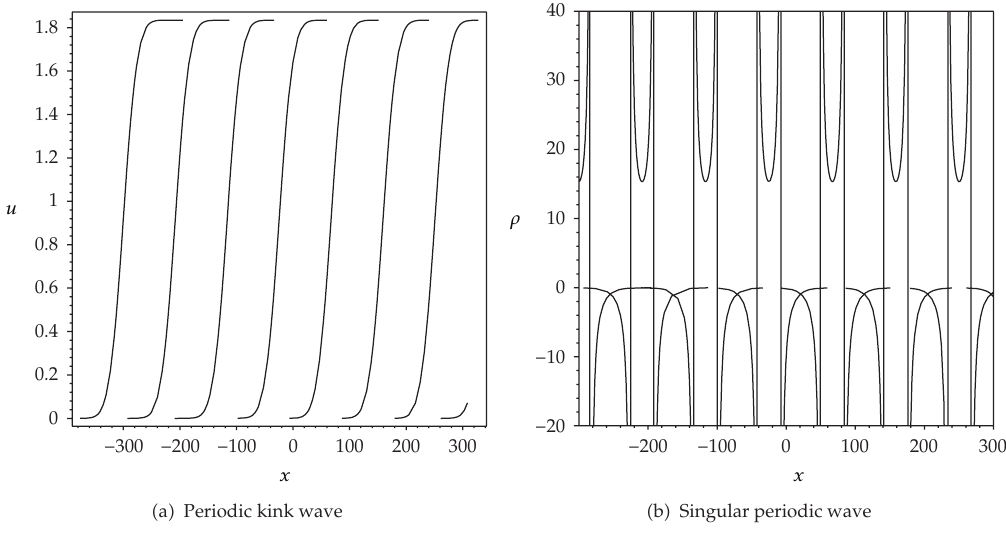
Figure 6: The profiles of noncontinuous periodic waves of solutions (cid:2) 3.23 (cid:3) and (cid:2) 3.24 (cid:3) for the given parameters: (cid:2) a (cid:3) κ (cid:7) − 4 , m (cid:7) 0 . 6 , t (cid:7) 1; (cid:2) b (cid:3) κ (cid:7) − 2 , m (cid:7) 0 . 6 , t (cid:7)